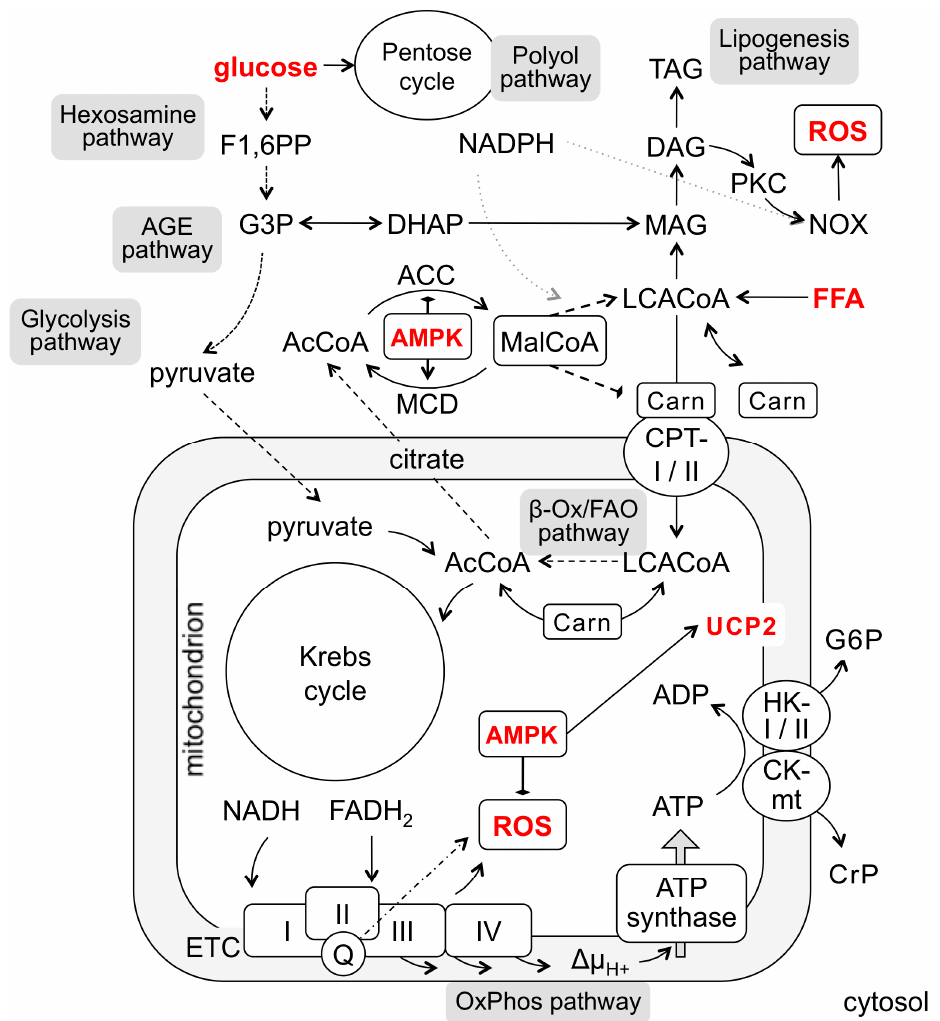
Figure 2. Endothelial metabolic wires altered by hyperlipidemia and hyperglycemia. The major pathways are indicated as grey boxes. Molecular actors in main focus are marked in red. The scheme embraces cytosolic carbohydrate metabolism (top left) and fatty acid turnover (top right); utilization of these substrates in mitochondria for energy production is boxed underneath. Abbre- viations: ACC, acetyl-CoA carboxylase; AcCoA, acetyl-coenzyme A; ADP, adenosine diphosphate;